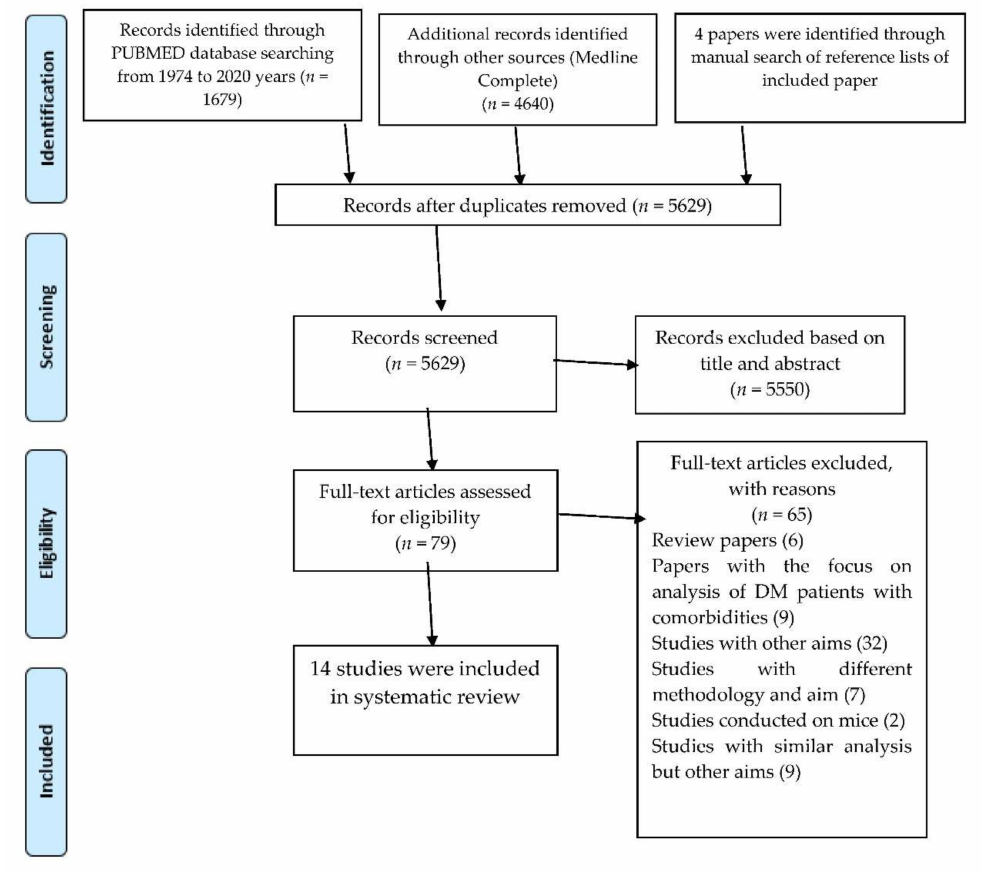
Figure 1. PRISMA Flow